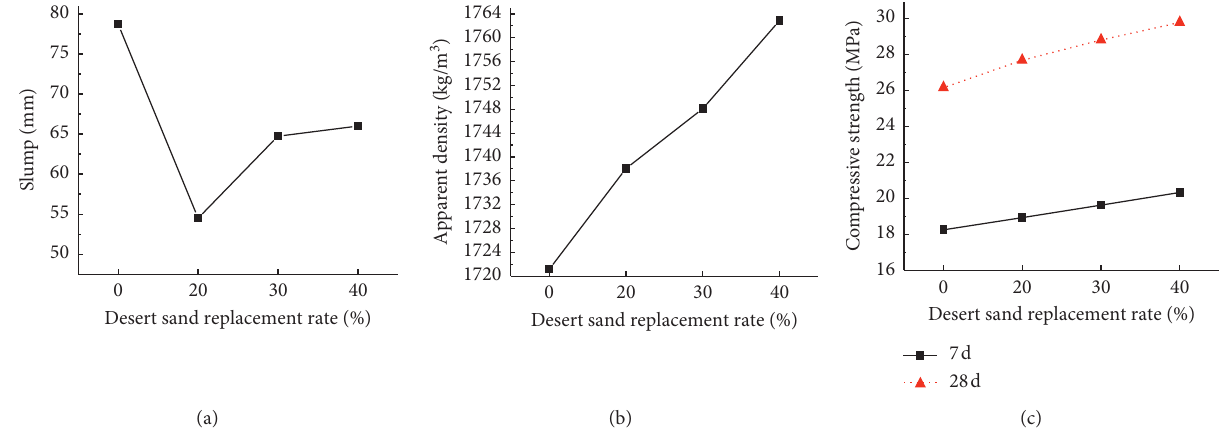
Desert sand replacement rate (%)